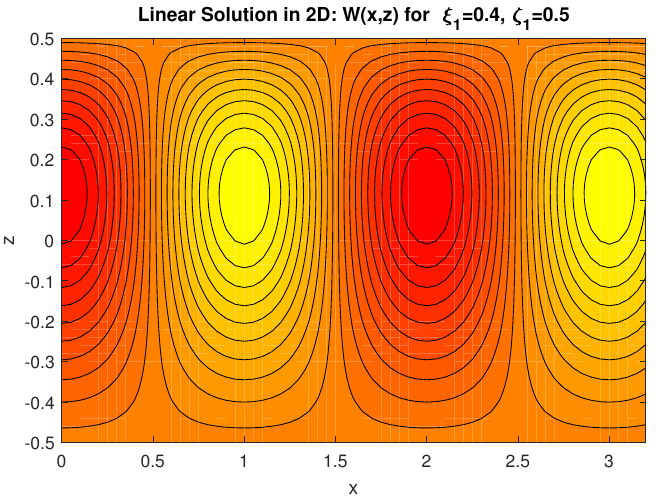
Figure 12. Linear 2D solution for W , i.e., (cid:101) ( W 10 ( x , z ) + δ W 11 ( x , z )) . The linear solution (cid:101) ( θ 10 ( x , z ) + δθ 11 ( x , z )) is shown in Figure 13.